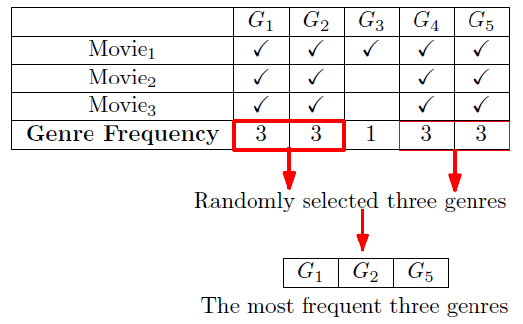
Figure 31. Example of selecting the top three genres.